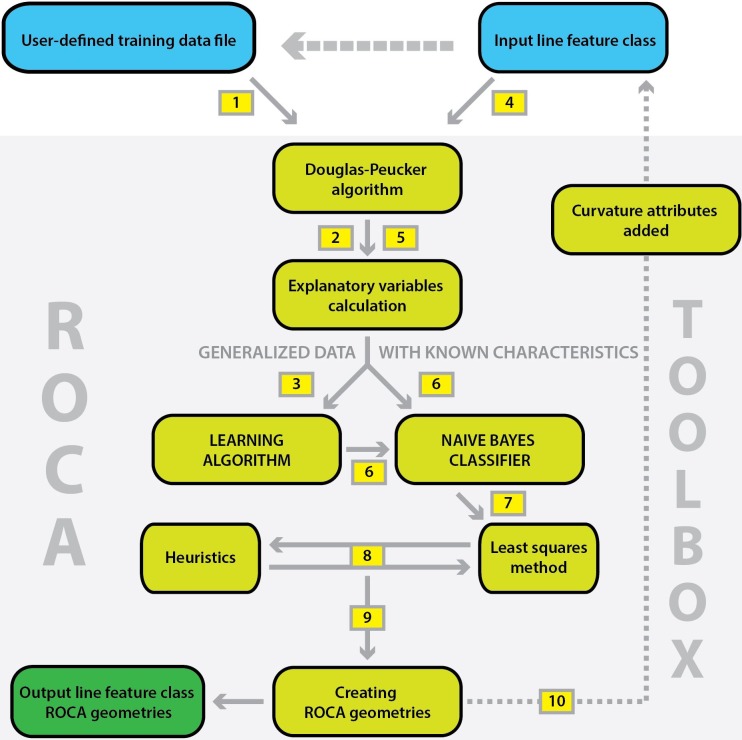
ROCA flow chart.